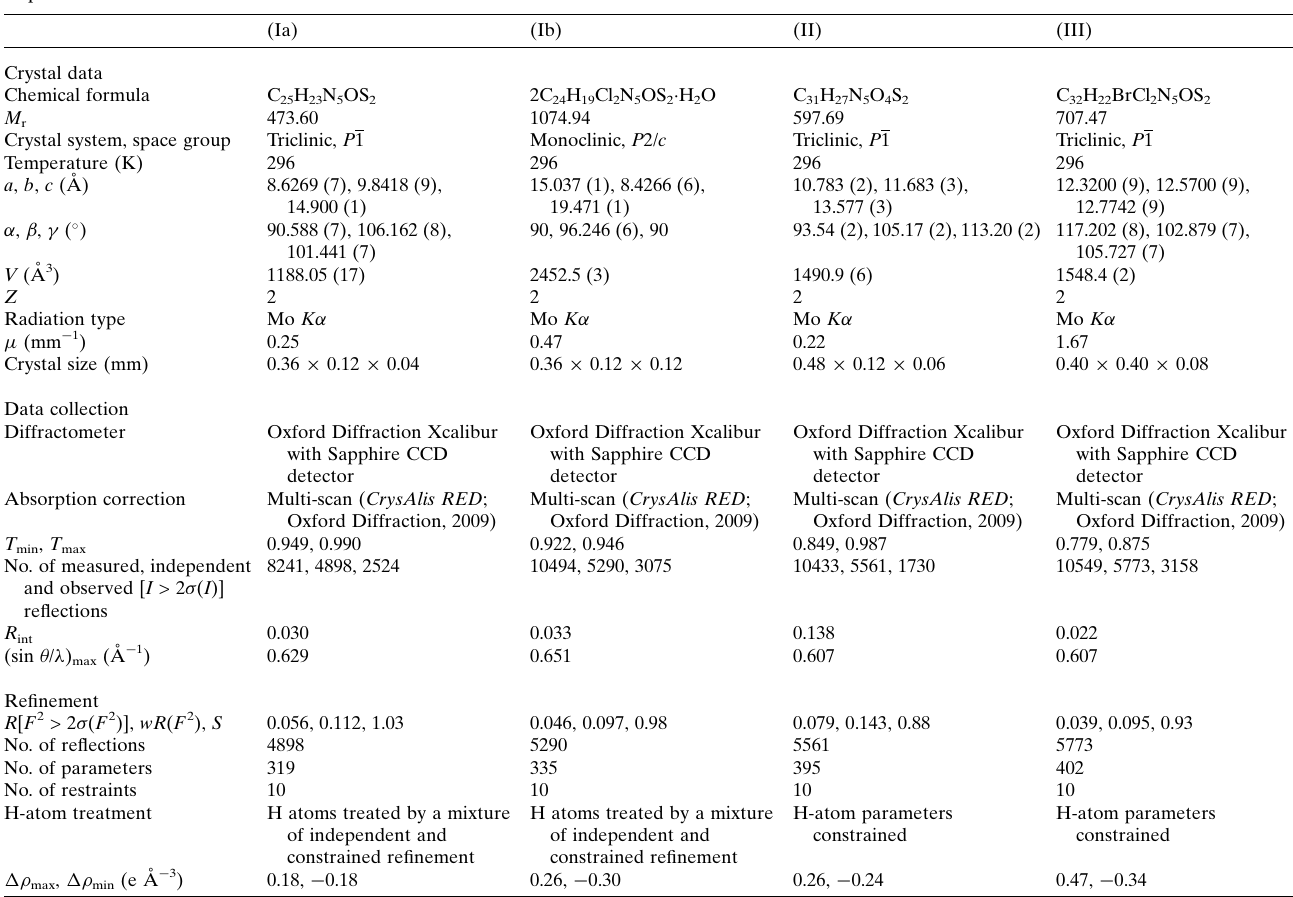
Table 2 Experimental